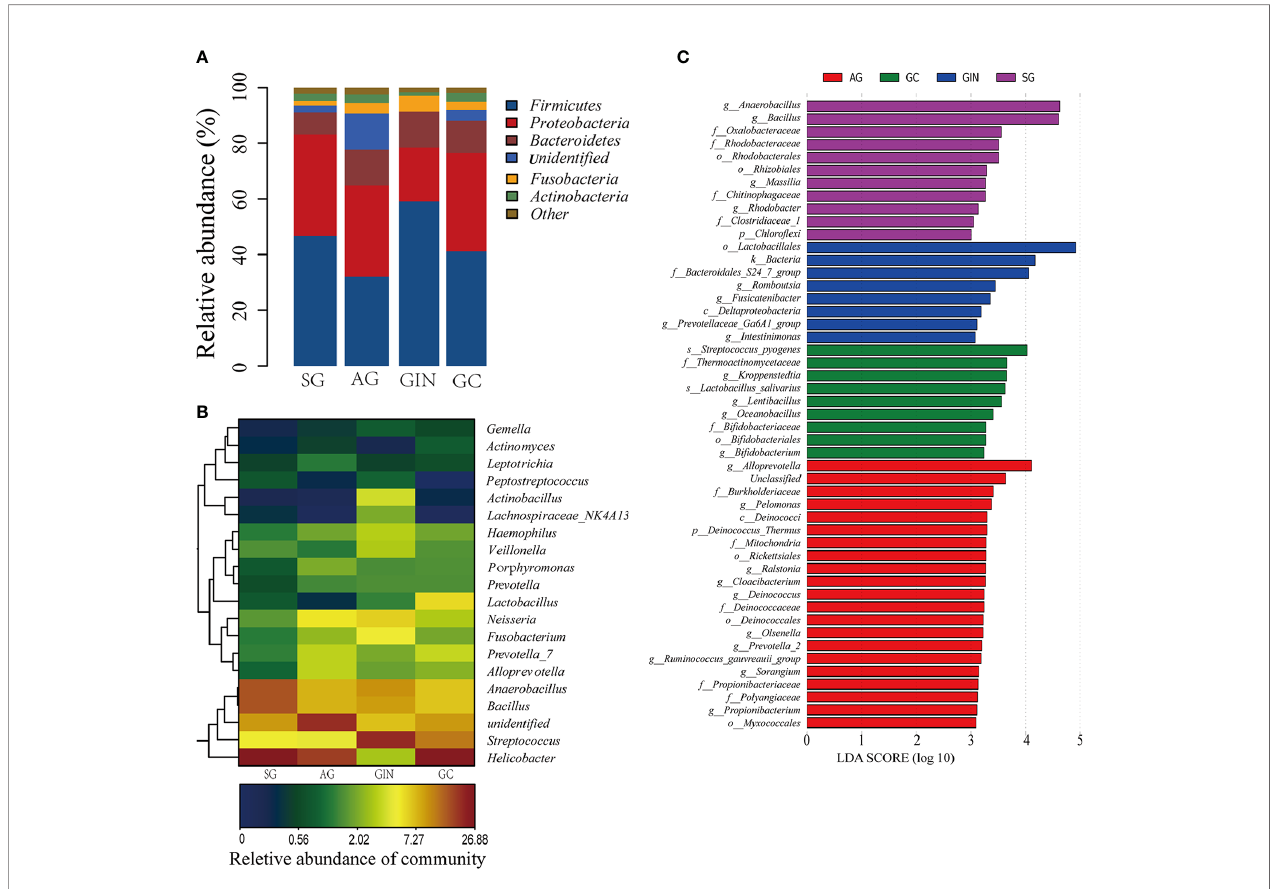
FIGURE 2 | The microbiota composition in different groups. (A) Relative abundance of phyla in four groups. (B) Heatmap of 20 genera with the highest relative abundance in four groups. (C) Histogram of the linear discriminant analysis (LDA) scores for differentially abundant taxonomic features among four groups. Signi fi cance obtained by LDA effect size (LEfSe) at p < 0.05 (Kruksal – Wallis test) and LDA score>3 (f:phylum, c:class, o:order, f:family, g:genus,